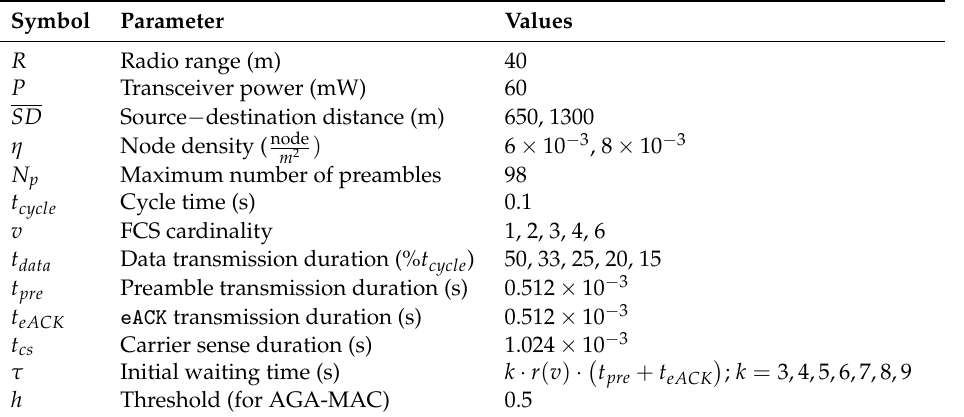
Table 4. Parameters used for simulation